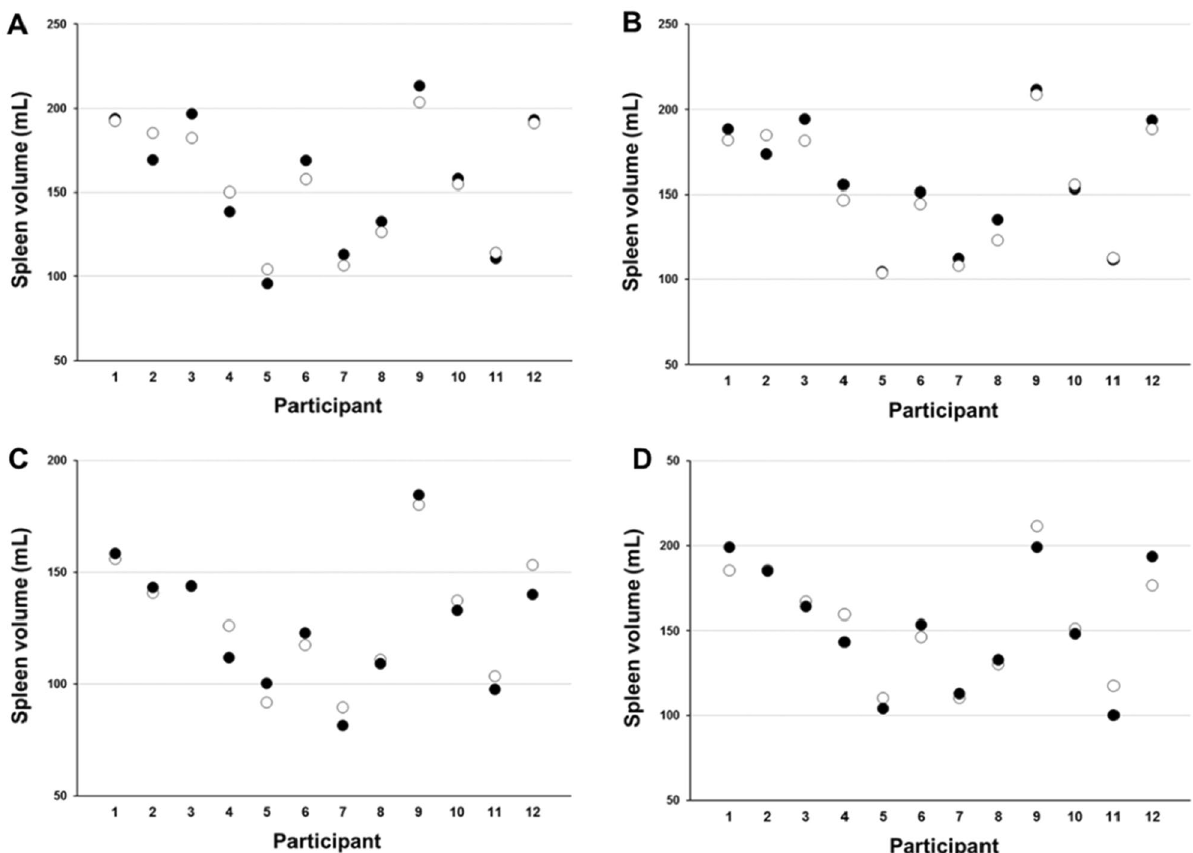
Figure 3. Individual splenic volumes for test 1 (black dots) and test 2 (white dots) for baseline (resting) splenic volume as calculated by ‘two consecutive maximal measures’ (mL; A ), baseline splenic volume as calculated by ‘mean of all measures’ (mL; B ), apnea-induced splenic volume and (mL; C ) after five minutes of recovery (mL; D ) for each participant using formula (1) (n = 12).